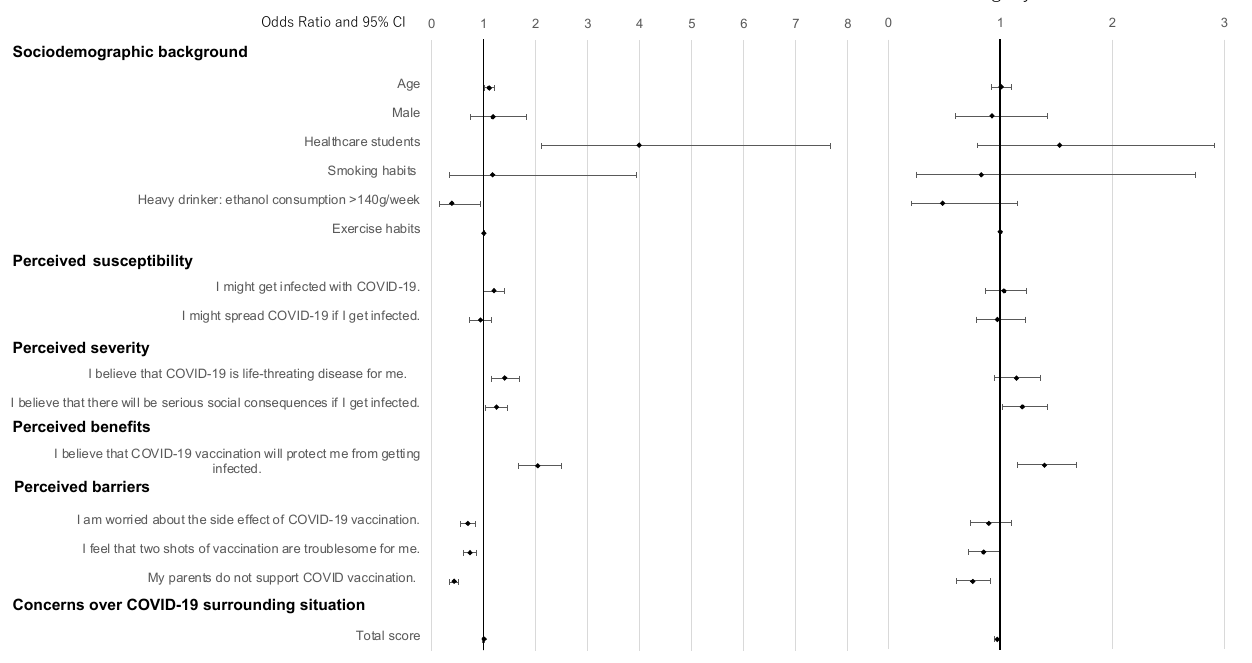
Figure 1. Logistic regression analyses of vaccine intention.